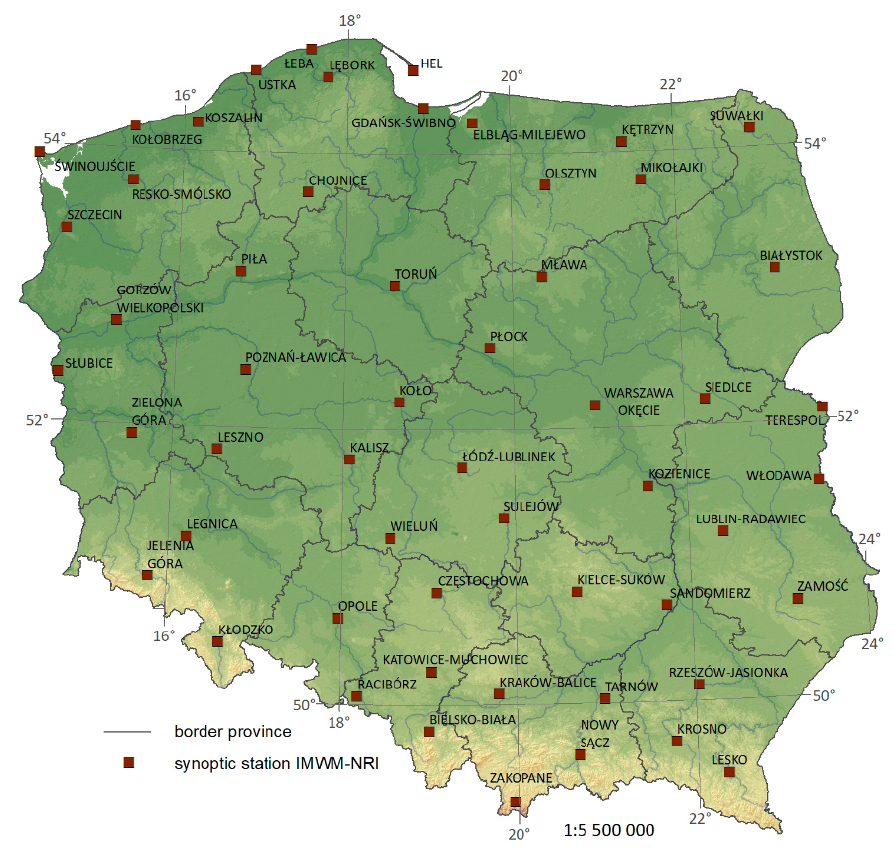
Figure 2. Localization of 55 synoptic stations used in the study.